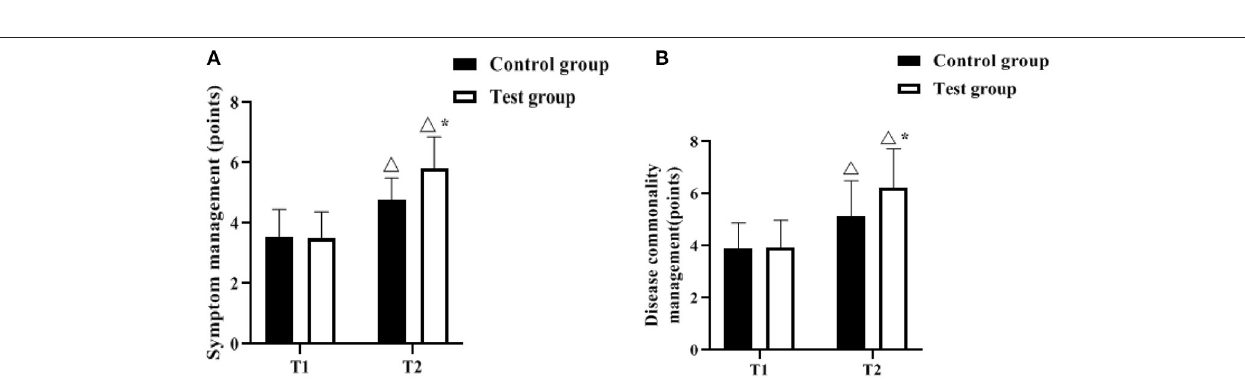
FIGURE 3 | Comparison of barthel index, medication adherence, PDQ-39 scores ( n , x ± s). (A–C) indicate the Barthel Index, Medication adherence and PDQ-39 scales, respectively. Icon 1 indicates the difference between T2 period and T1 period between the same groups, P < 0.05. Icon * indicates the difference between the two groups in T2 period, P < 0.05.